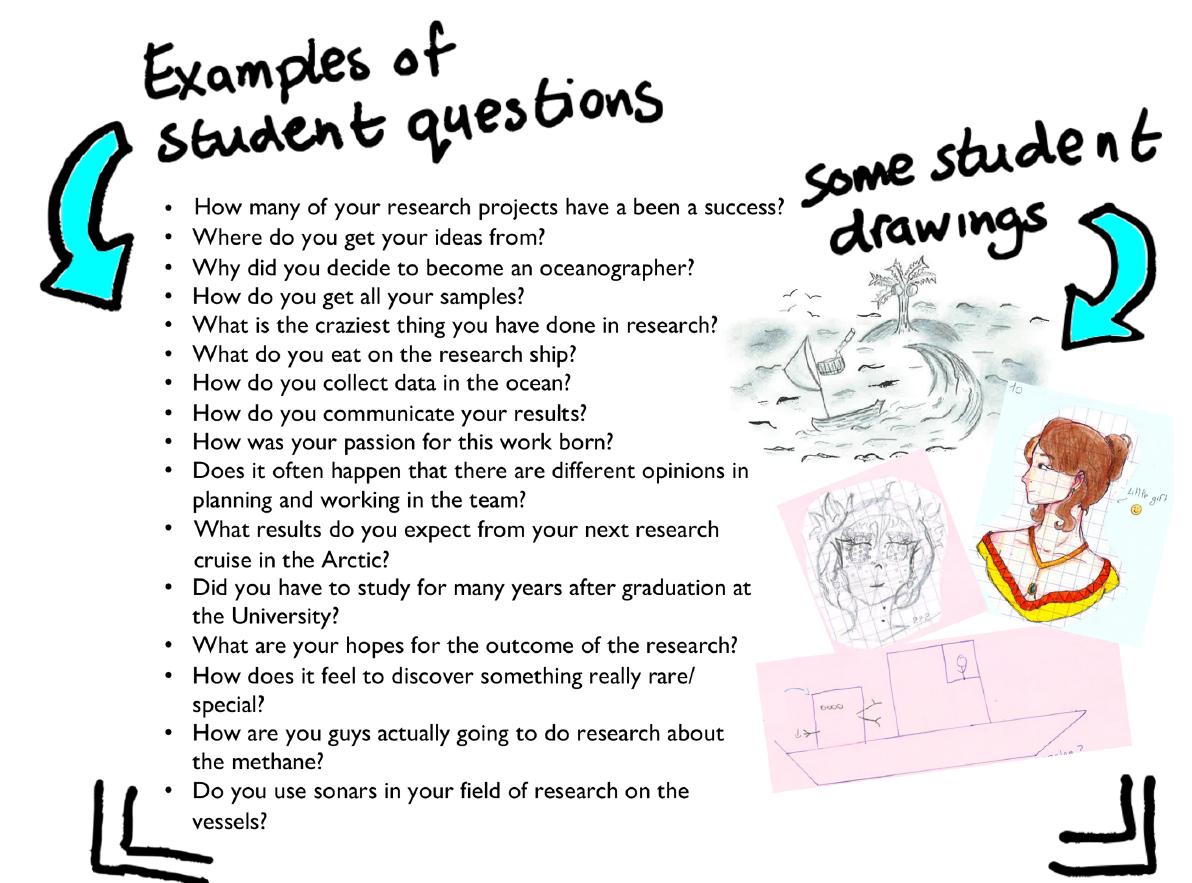
Figure 2. Examples of some of the questions the students wrote to the scientists after their teachers had gone through what a research process looks like and introduced them to their scientist. Here are also some of the pictures the students included in their handwritten